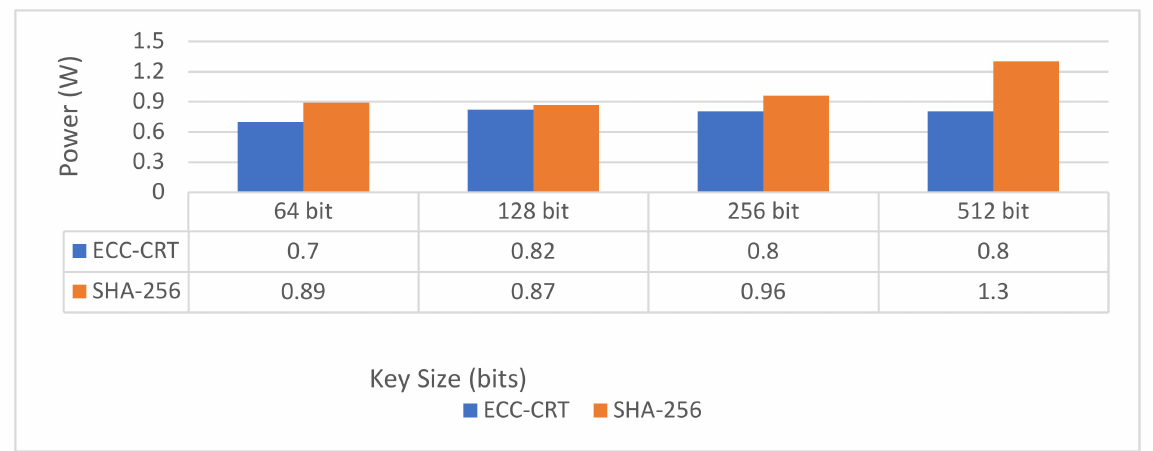
Figure 9. Power consumption of ECC-CRT and